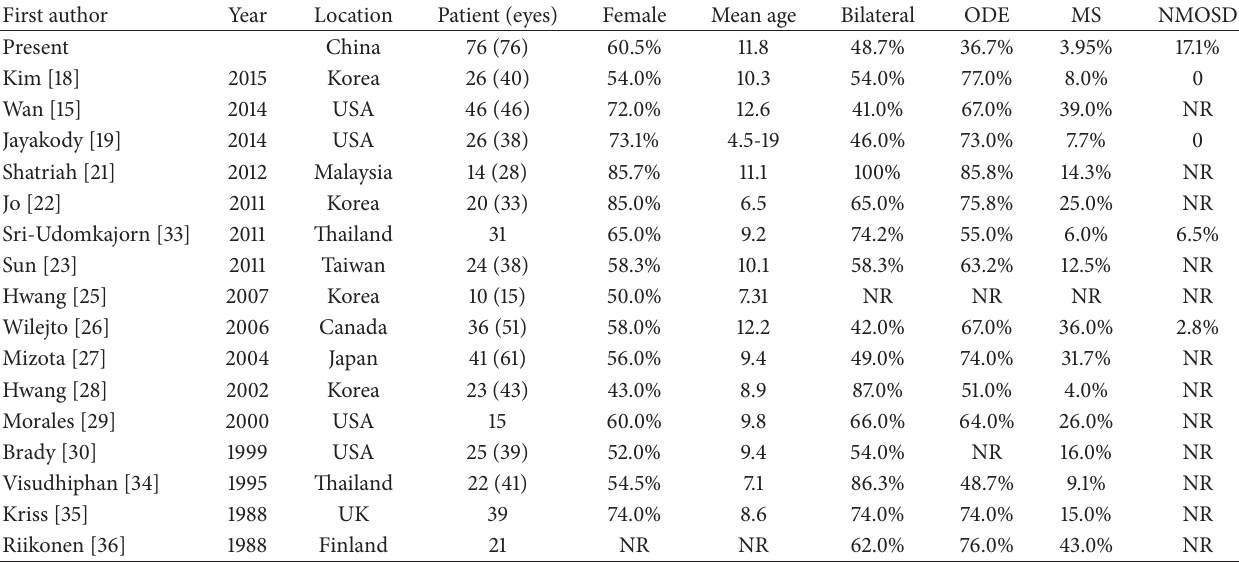
Table 4: Clinical features of children optic neuritis in previous published